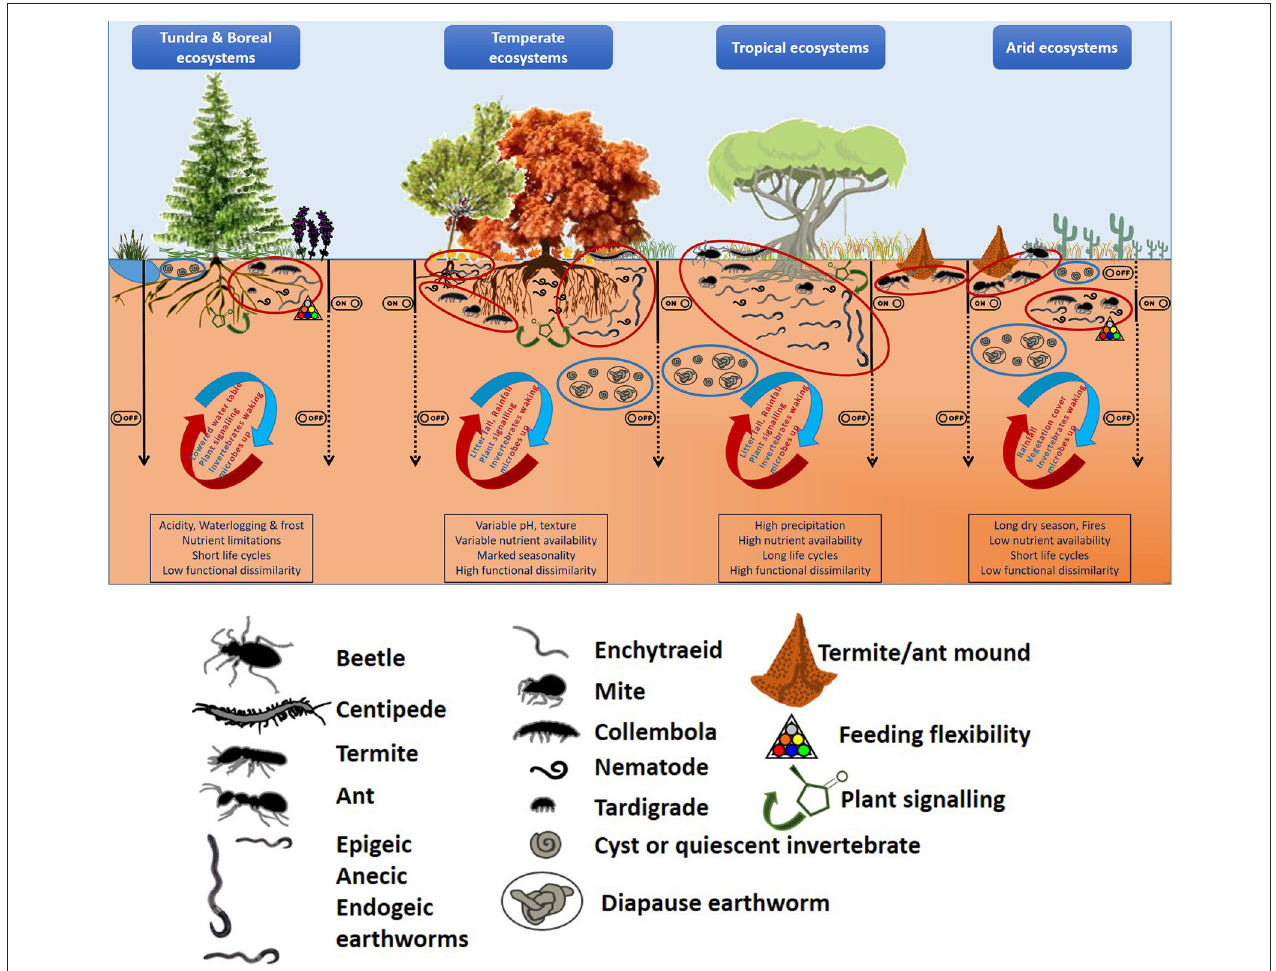
FIGURE 1 | Linking hotspots and hot moments of soil fauna to climatic gradients and soil heterogeneity: Historical factors (climate, parent material) shape our landscapes (both above- and below-ground), but the regional/local abiotic conditions constraint biological activities. These operate at different spatial and temporal scales and can switch on and off different organisms at different microsites resulting in a hot moment in a particular hotspot. Since each of their responses can have effects on others, their effects could then cascade up and down in the food web. Soil invertebrates are depicted not in scale, just for illustrative purposes (see pictorial legend for major taxonomical groups). Ellipses indicate hot (red) or cold spots (blue), with the curved arrows giving some examples of the factors that could switch on/off a hot moment and the straight black arrows (continuous black line = on, dashed = off) showing the implications for soil processes along the soil profile. In the boxes, the main ecosystem characteristics are